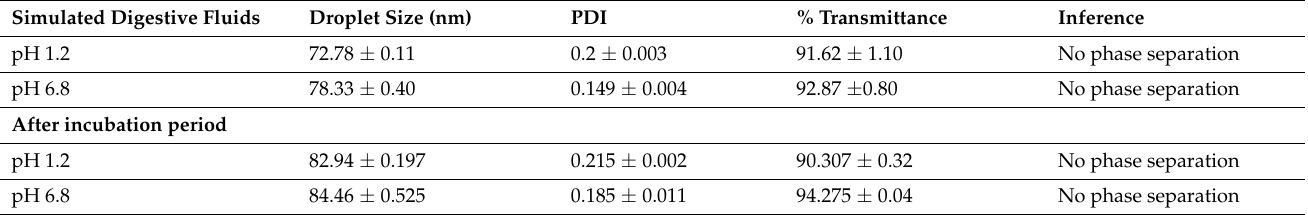
Table 3. Reconstitution behavior stability of s-SNEDDS in simulated gastrointestinal